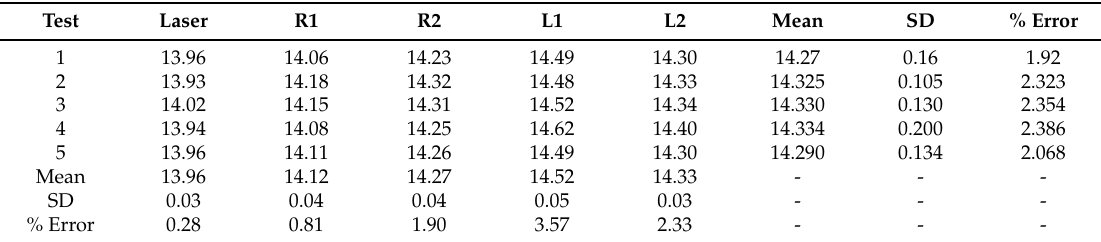
Table 1. Fourteen meter straight line distance test results. Comparing the distance from the laser, and the independently found distance from each of the four wheel sensors (R1, R2, L1, L2) to the known 14 m distance from the court markings.